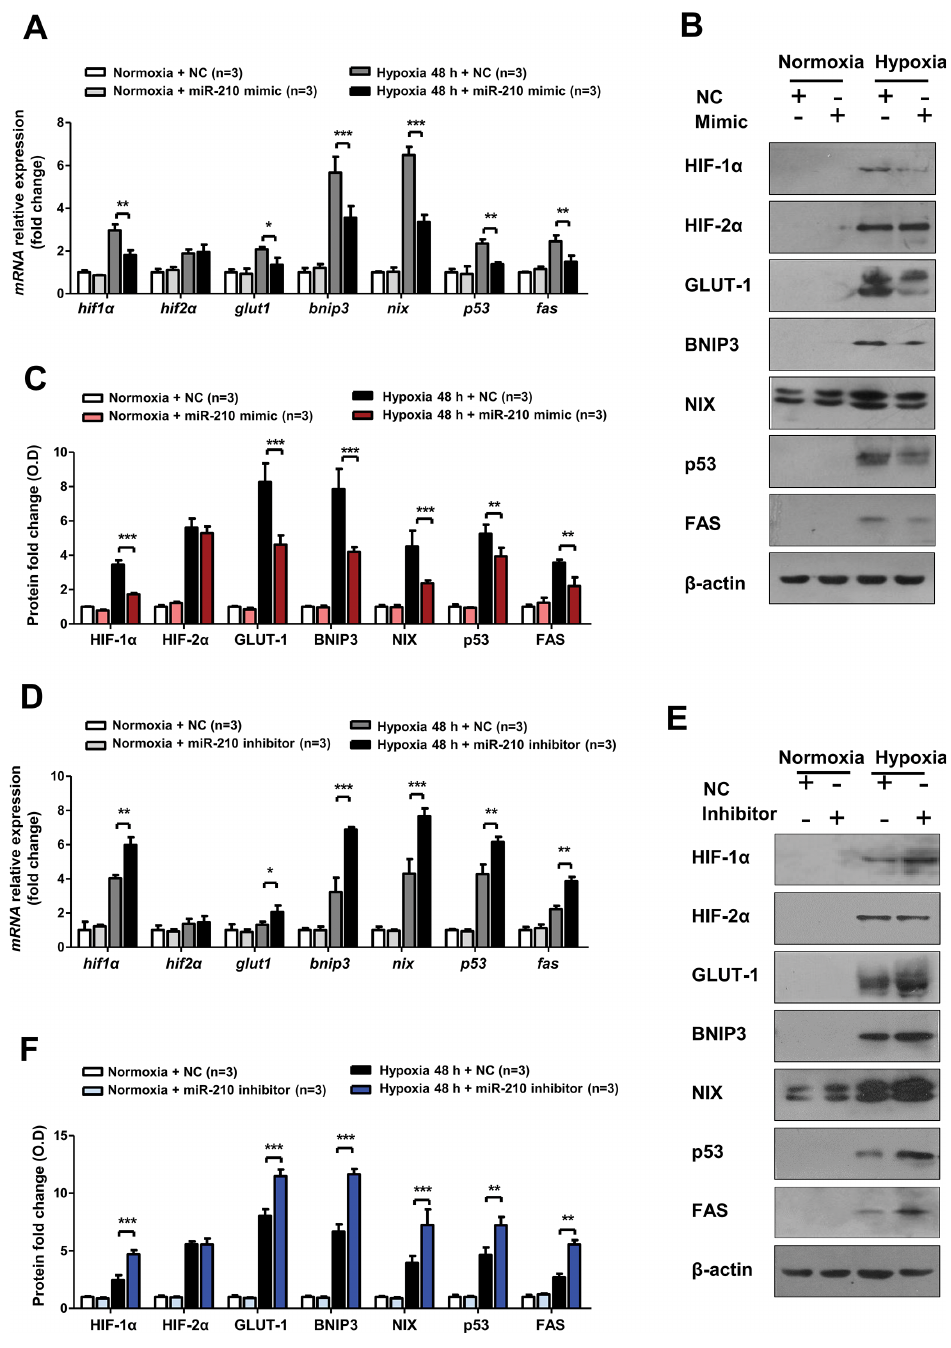
Figure 7. miR-210 overexpression suppressed HIF-1 α pathway activation in HK-2 cells after hypoxia, while miR-210 knockdown displayed the reverse effect. (A)Real-time PCR and (B) representative Western blotting were employed to detect the mRNA and protein expression levels of the HIF-1 α pathway genes (HIF-1 α , GLUT-1, BNIP3 and NIX), HIF-2 α and the pivotal apoptotic genes (p53 and FAS) in HK-2 cells transfected with a miR-210 mimic and negative control under normoxia (21% O ) or hypoxia (0.3% O ) conditions for 48 h. (C) Optical 2 2 density quantitative analysis of Western blots in (B). Regarding miR-210 inhibitor transfection, the mRNA expression levels of the above- mentioned genes are shown in (D), and the corresponding protein expression are shown in (E). The optical density quantitative analysis of Western blots in (F). All quantitative results are from three independent experiments. All mRNA expression levels and Western blotting relative expressions were compared with β -actin (n = 3). Data are shown as mean ± SD. * P < 0.05; ** P < 0.01; *** P <